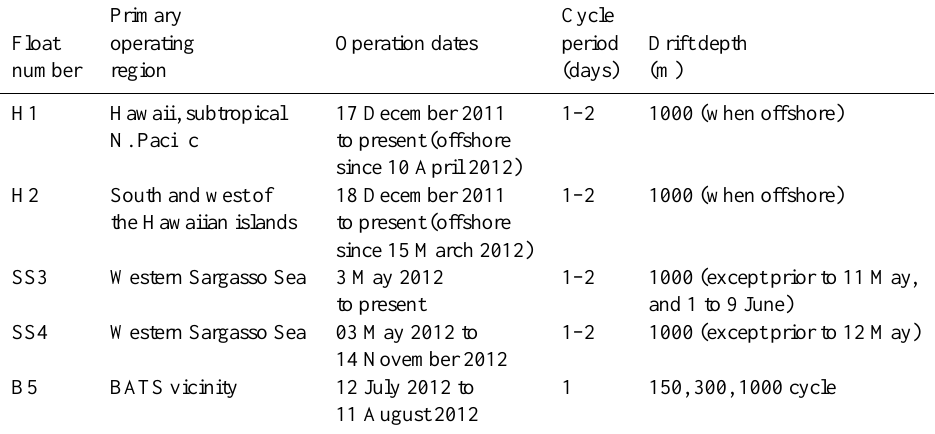
Table 1. Float deployment